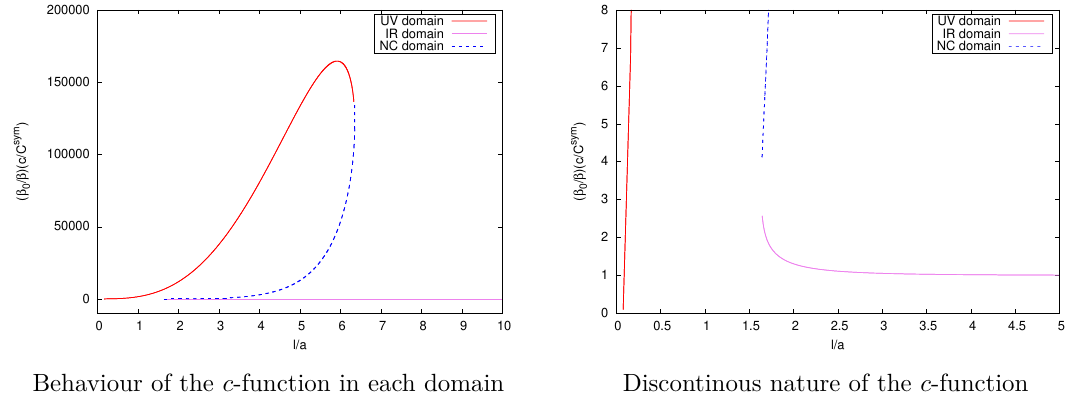
Figure 3 . Behaviour of the c -function for all possible values of l